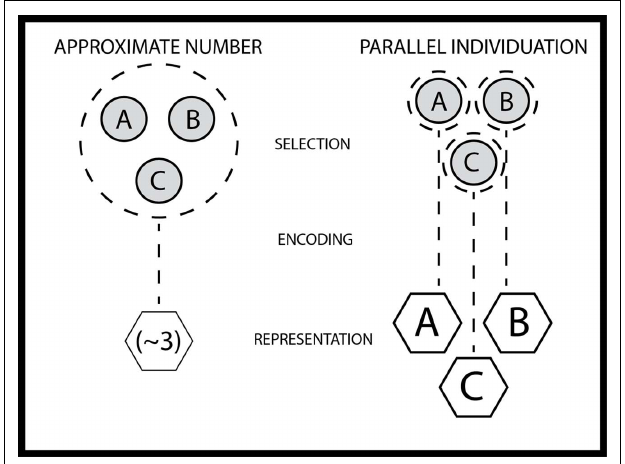
FIGURE 1 | Schematic depiction of number representation through the approximate number system and the parallel individuation